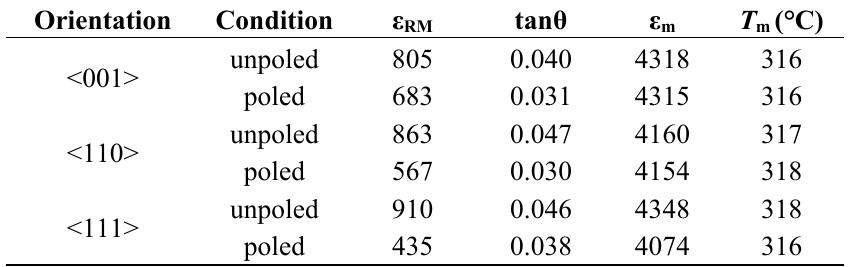
Figure 8. (Color online) Polarization hysteresis loops of the <001>, <110>, and <111> oriented 0.92NBT-0.08KBT crystals at room temperature. Reprinted with permission from [25]. Copyright 2011 AIP Publishing LLC. Table 1. Dielectric parameters for the unpoled and poled 0.92NBT-0.08KBT single crystal (1 kHz) (poling condition: E p = 3 kV/mm, T p = 50 °C and t p = 15 min). Reprinted with permission from [25]. Copyright 2011 AIP Publishing